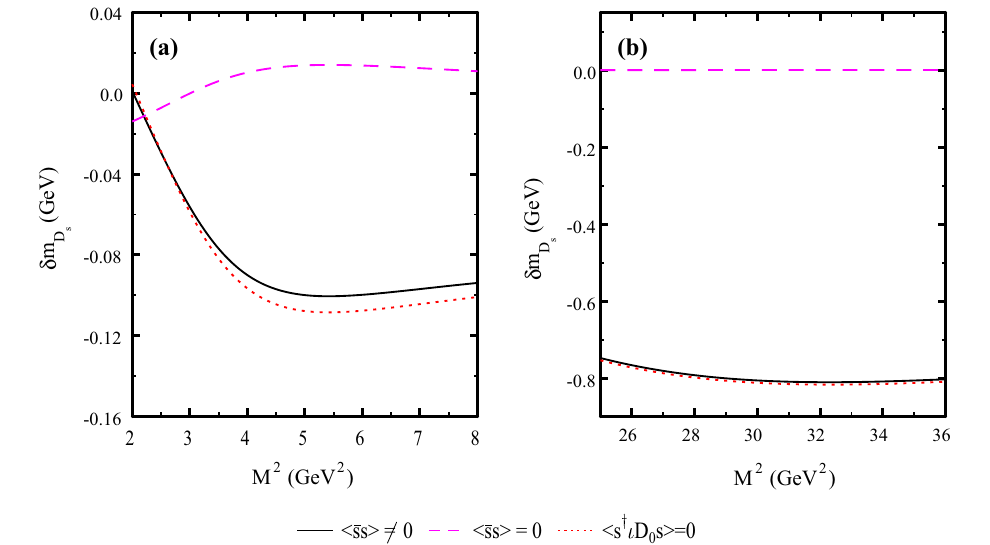
Table 2 Contribution of individual condensates on the shift in the mass of the D s meson (in MeV) for two values of temperatures ( T = 0 and 100 MeV), strangeness fraction ( f s = 0 and 0.5) and